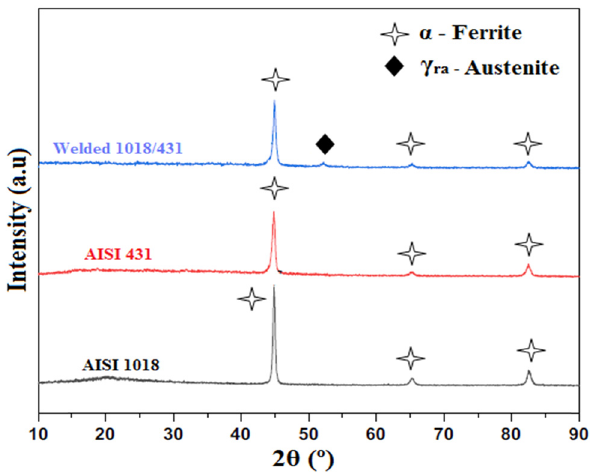
Figure 10: XRD patterns of AISI 1018 steel, AISI 431 steel, and dis - similar rod - to - plate